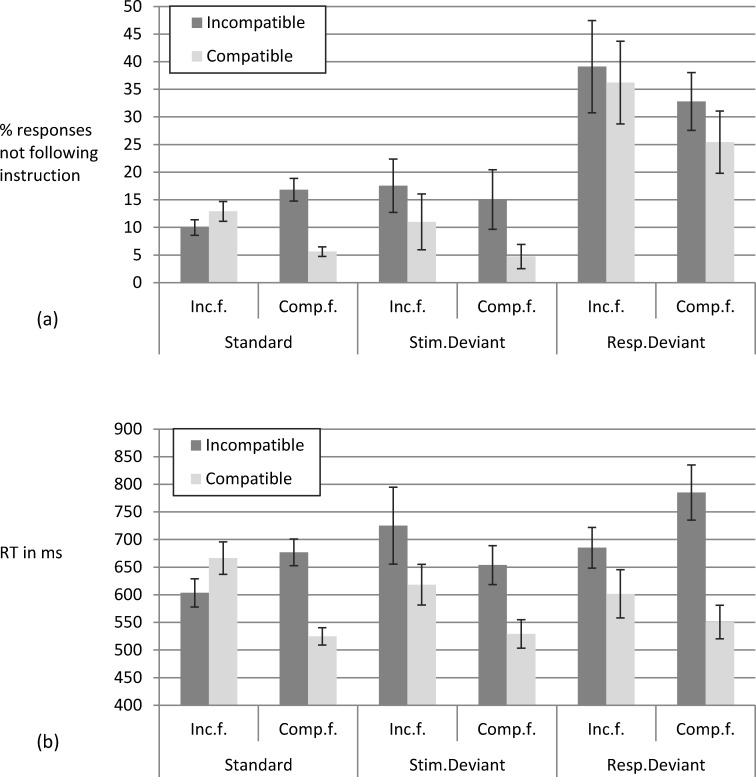
Exp. 2: Spatial compatibility.Panel (a) shows the % of responses not following the instructed stimulus feature position for standard trials, stimulus deviant trials, and response deviant trials of Block 10, differentiating between spatially compatible and incompatible trials for the compatibles frequent and the incompatibles frequent condition. Panel (b) shows mean RTs. Error bars depict the between subjects standard error of the mean.